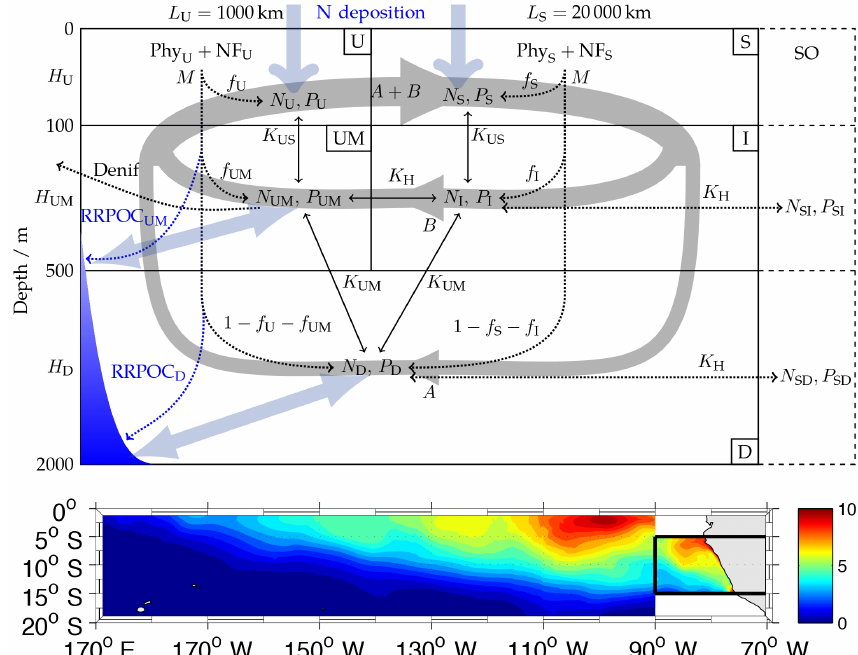
Figure 1. Model structure. The model domain comprises five boxes representing the top 100m of an upwelling region (U), the underlying oxygen minimum zone (UM), and an adjacent open-ocean basin divided into a surface (S) and an intermediate-depth box (I). A deep box (D) underlies both the upwelling region and the open ocean. The large-scale circulation is represented by deep (A) and shallow (B) convection (thick grey lines). Mixing between boxes is implemented via mixing coefficients ( K ). Remineralisation derived from primary production by ordinary (Phy) and diazotrophic (NF) phytoplankton in the surface boxes consumes oxygen. Under anoxic conditions remineralisation is fuelled by anaerobic remineralisation (Denif). In the configuration employed in this study, the model domain exchanges nutrients and oxygen with the Southern Ocean (right, denoted as “SO”). Nitrogen deposition and benthic remineralisation are included additionally to represent their influence on the local water-column nutrient concentrations (thick light blue arrows). The graph above is a schematic figure of our model domain; the graph below shows the surface of our model domain, and the colour bar is nitrate concentration in µmolL − 1